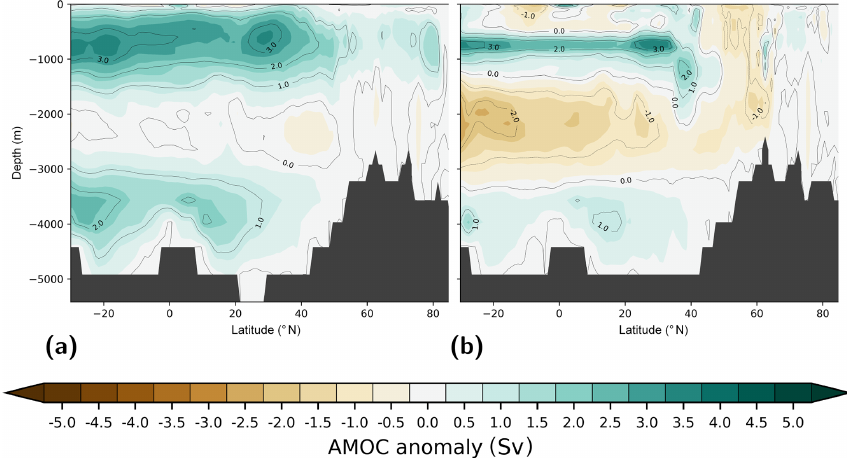
Figure 18. Atlantic Ocean Meridional Overturning Circulation (AMOC) anomaly with respect to pre-industrial (E280) in Sverdrups (1Sv ≡ 10 6 m 3 s − 1 ) visualised via the basin-wide zonal- and time-integrated stream function. Shown are (a) E600 and (b) Eoi400_GW. Positive AMOC anomalies illustrate a change towards clockwise circulation from the viewpoint of Europe and Africa. Dark grey shading illustrates bottom topography zonally averaged across the